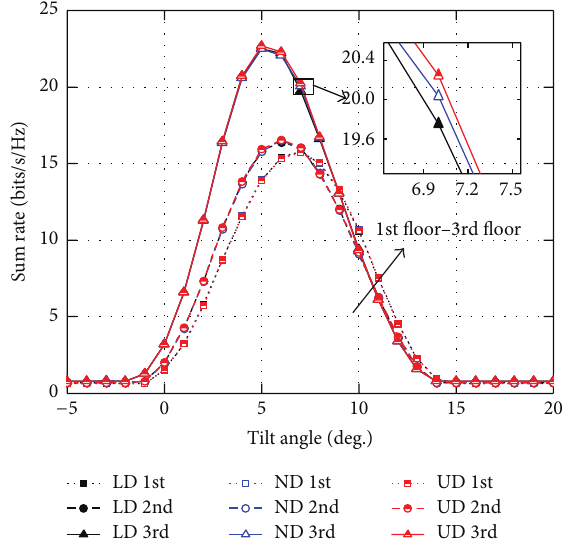
Figure 6: Simulated sum rate against the tilt angle of each floor for three user distributions ( 𝑝 𝑢 = 5 dB, 𝑁 𝑟 = 50 , 𝑁 𝑡 = 2 , 𝐿 = 3 , 𝐾 = 24 , 𝐷 = 1000 m, 𝜐 = 4 , 𝐿 = 3 , 𝐾 = 24 , 𝐷 = 1000 m, 𝜐 = 4 , 𝑅 = 100 m, UD: uniform distribution, ND: normal distribution, and LD: linear